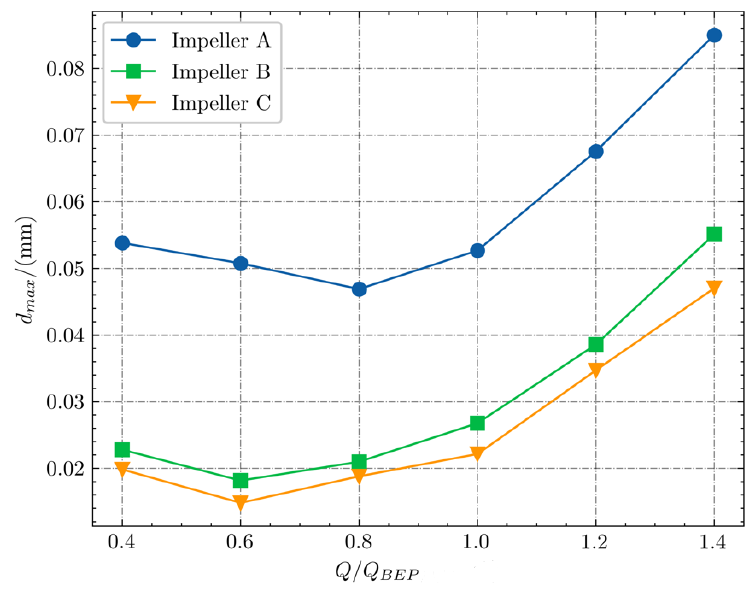
Figure 13. Curves of maximum deformation of different impeller rotors with flow.